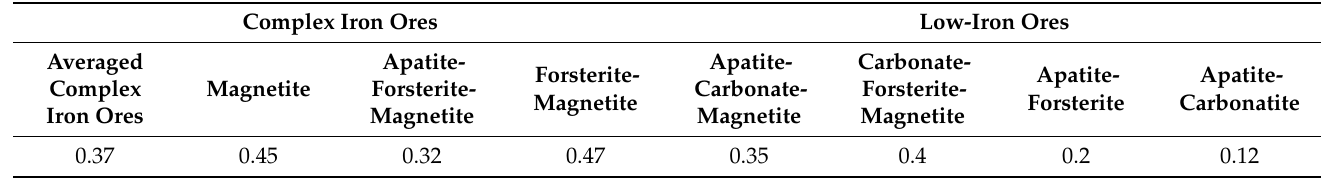
Table 8. MnO content (%) in the ores of the Kovdorsky baddeleyite-apatite-magnetite deposit. Complex Iron Ores Low-Iron